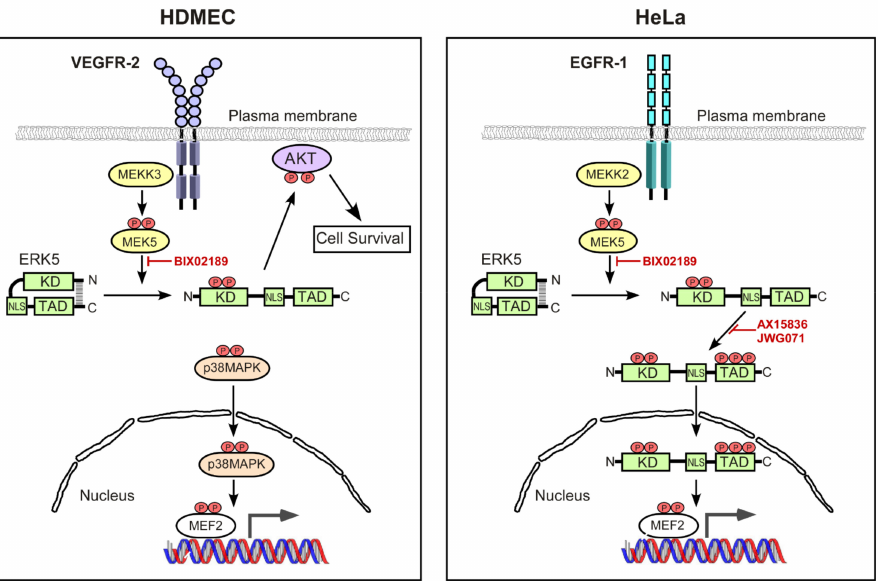
Figure 8. Schematic diagram of differential ERK5 activation by VEGF in endothelial cells and EGF in HeLa cells. Ligand-mediated activation of EGFR-1 in HeLa cells activates MEK5 predomi- nantly via MEKK2, resulting in the phosphorylation of ERK5 on the activation-loop T-E-Y motif in the ERK5 kinase domain, resulting in a conformational change in ERK5 and facilitating phosphorylation of ERK5 on multiple residues in the C-terminal transcriptional transactivation domain (TAD). The nuclear localisation sequence (NLS) within the C-terminal domain is now able to promote a nuclear localisation of ERK5. ERK5 is thought to drive MEF2-dependent gene expression by both directly phosphorylating MEF2 transcription factors and by the involvement of the ERK5 TAD. In contrast, ligand-mediated activation of VEGFR-2 in endothelial cells activates MEK5 via MEKK3, resulting in the phosphorylation of ERK5 on the activation-loop T-E-Y motif in the ERK5 kinase domain. However, ERK5 does not undergo phosphorylation in the C-terminus and is unable to translocate to the nucleus, and is instead localised to the cytoplasmic and plasma membrane area ultimately allowing phosphorylation of AKT and suppression of apoptosis in endothelial cells. In contrast to p38